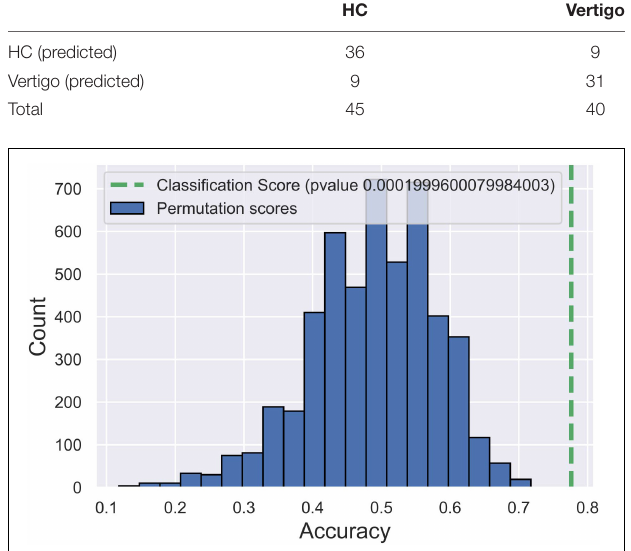
FIGURE 4 | Post hoc test for support vector machine (SVM) model via permutation testing. The green dotted line indicates the accuracy of our SVM model. Blue histograms indicate the accuracy distribution of SVM classifications in 5,000 randomly permutated datasets.